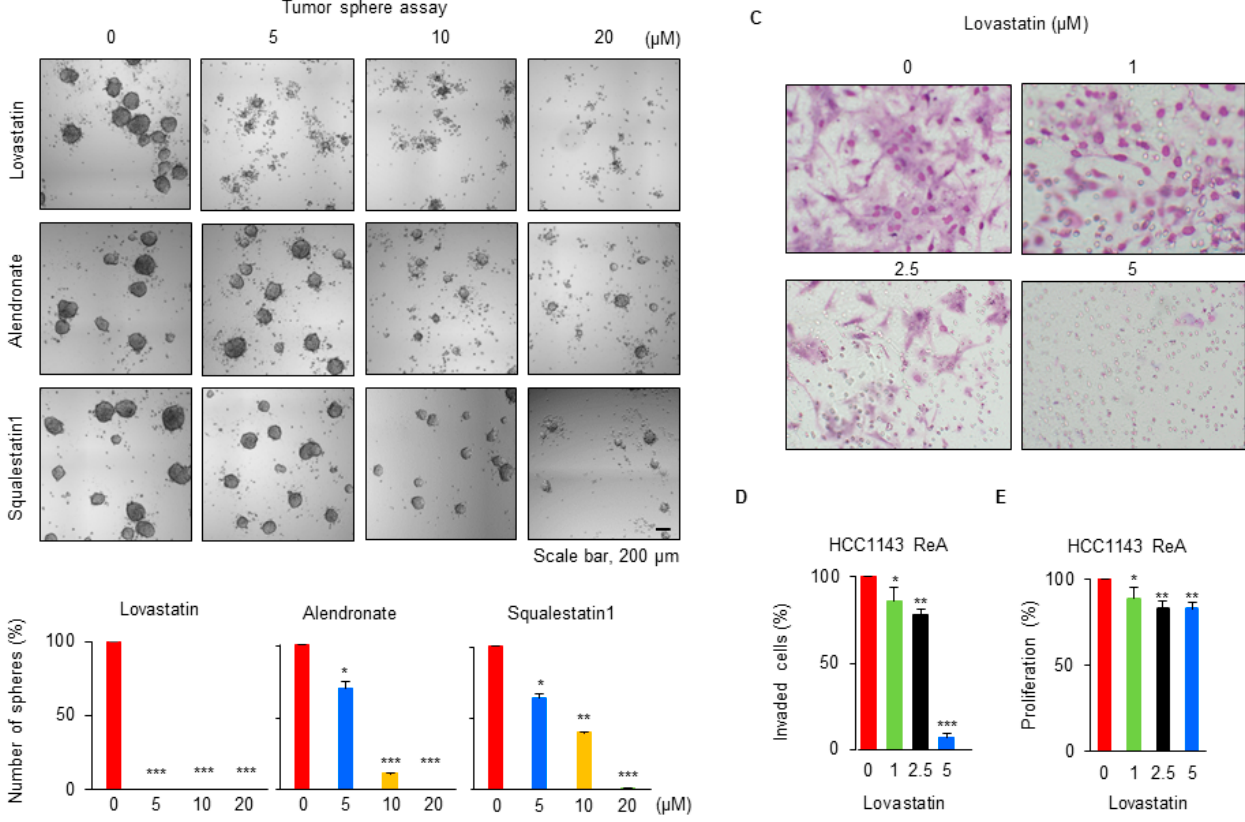
Figure 4. Cholesterol synthesis plays an important role in the malignancy of ReA cells. ( A ) The cholesterol biosynthesis inhibitors lovastatin, alendronate, and squalestatin1 affect TS formation. HCC1143 ReA cells were treated with the indicated concentrations of the drugs and cultured under TS-forming conditions for 7 days. Bright-field images of cells were taken with a Cytation 3 Cell Imaging Multi-Mode Reader. ( B ) The proportion of spheres was quantified as the mean ± standard deviation of three independent experiments. * p < 0.05, ** p < 0.01, *** p < 0.001 relative to non-treated cells. ( C ) HCC1143 ReA cells were treated with indicated concentrations of lovastatin for 48 h, and then seeded for Boyden chamber invasion assay. After 16 h, invaded cells were stained and counted. ( D ) The proportion of invaded cells was quantified as the mean ± standard deviation of three independent experiments. * p < 0.05, ** p < 0.01, *** p < 0.001 relative to no treat cells. ( E ) The effect of lovastatin on HCC1143 ReA cell growth under the conditions shown in Figure C was determined by SRB assay. Relative proliferative of cells was quantified as the mean ± standard deviation of three independent experiments. * p < 0.05, ** p < 0.01 relative to no treat